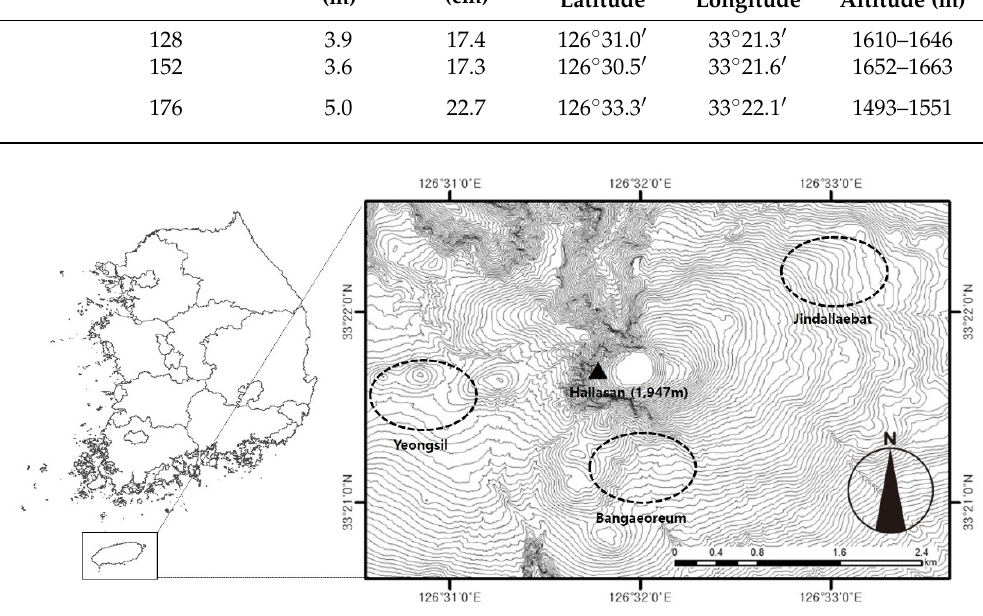
Figure 1. Location of Abies koreana on Mt. Hallasan.